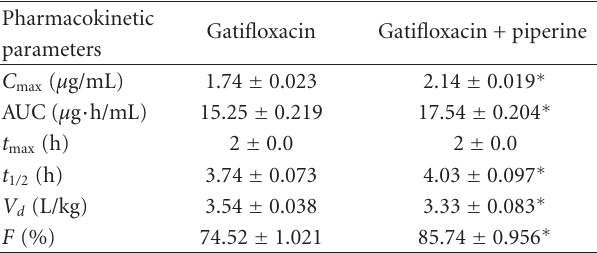
Table 17: Comparison of pharmacokinetic parameters of gatiflox- acin- and gatifloxacin + piperine-treated layer birds after single oral administration (10 mg/kg) [101].